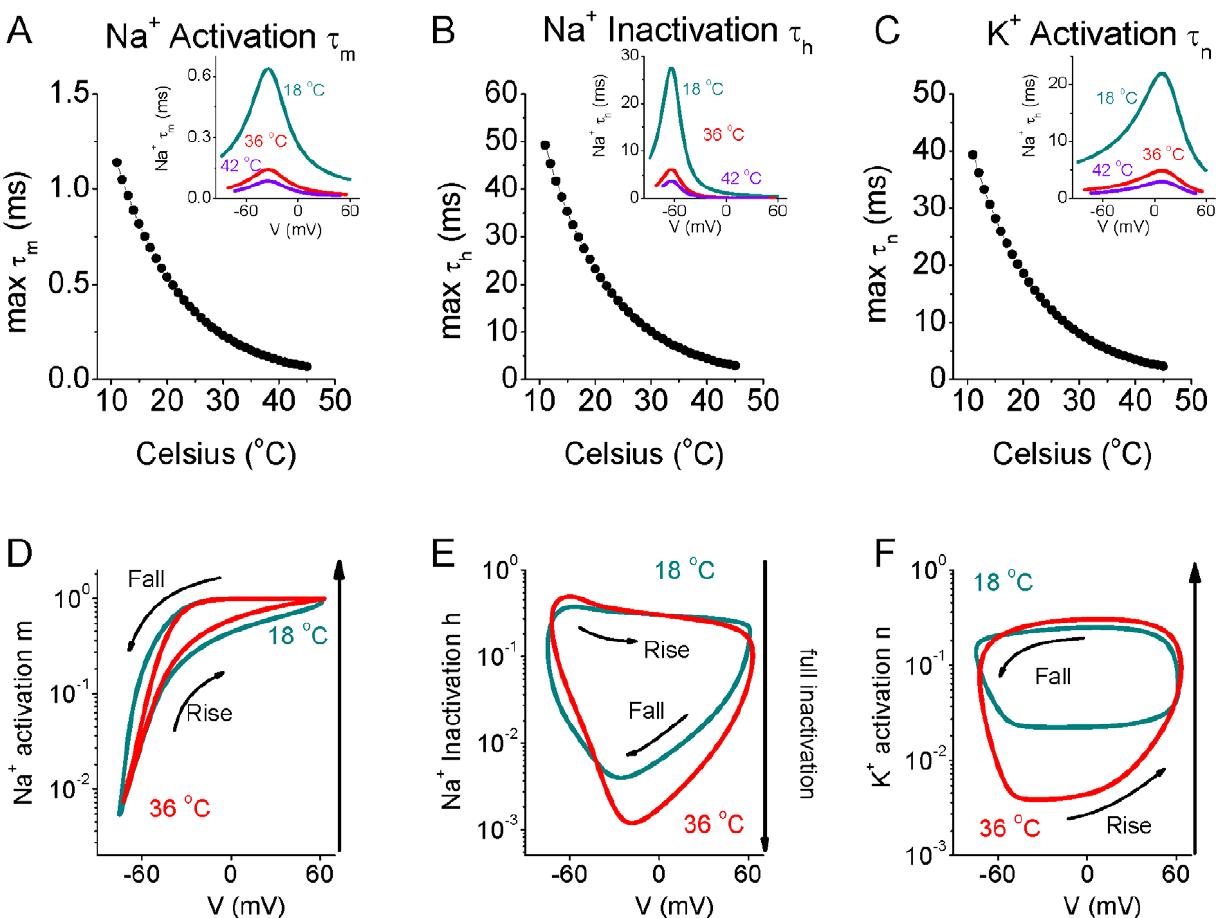
Figure 4. The kinetics of Na + and K + channels are heavily dependent on temperature change in the model neuron. A–C. The maximal value of Na + activation time constant t m (A) and Na + inactivation time constant t h (B), and K + activation time constant t n (C) as a function of temperature. Inset: Time constants of the variables as a function of membrane potential for temperature T=18 u C, 36 u C and 42 u C, respectively. D–F. Phase plots of membrane potential V vs. Na + activation variable m (D), Na + inactivation variable h (E) and K + activation variable n (F) for temperature T=18 u C, and 36 u C, respectively. Note that at 36 u C, the peak inactivation of the Na + current is considerably more complete (e.g. attains a lower value) (E) and the K + activation during the rising phase of the action potential is significantly less (F) than at 18 u C.